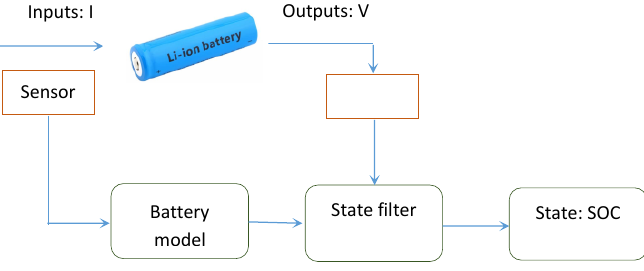
Figure 1. Flowchart of model-based battery SOC estimation algorithm.